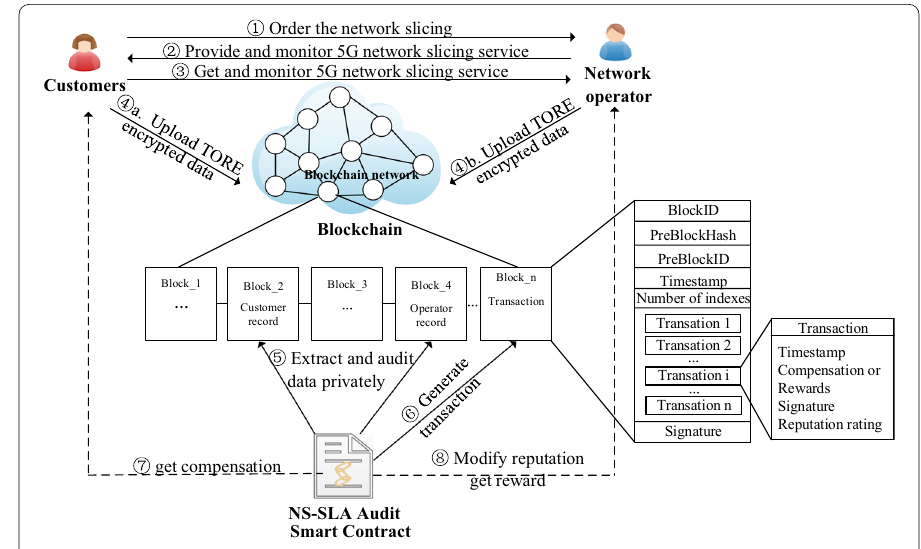
Fig. 2 System architecture for 5G NS-SLA audit model. The model of our scheme consists regional customers and network operator. This figure shows the audit process of our